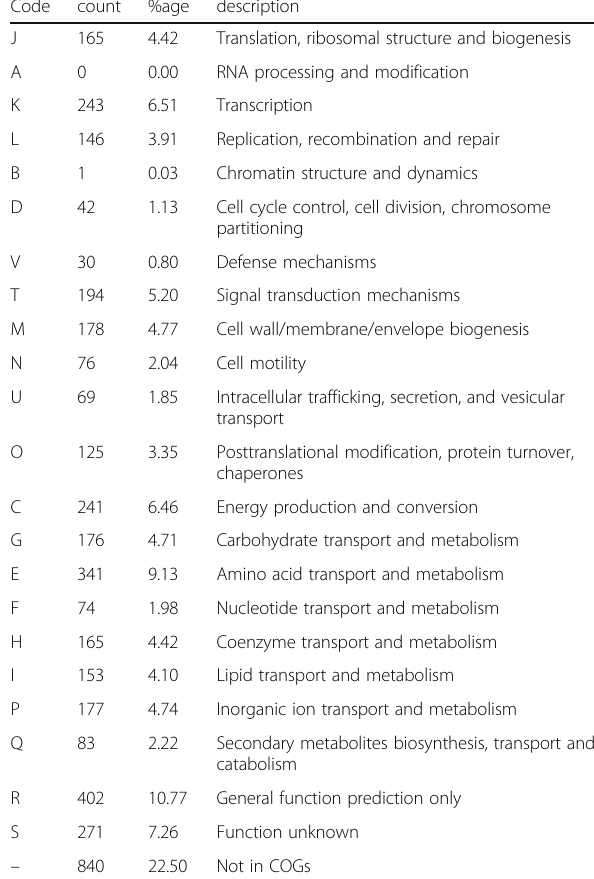
Table 4 Number of genes associated with general